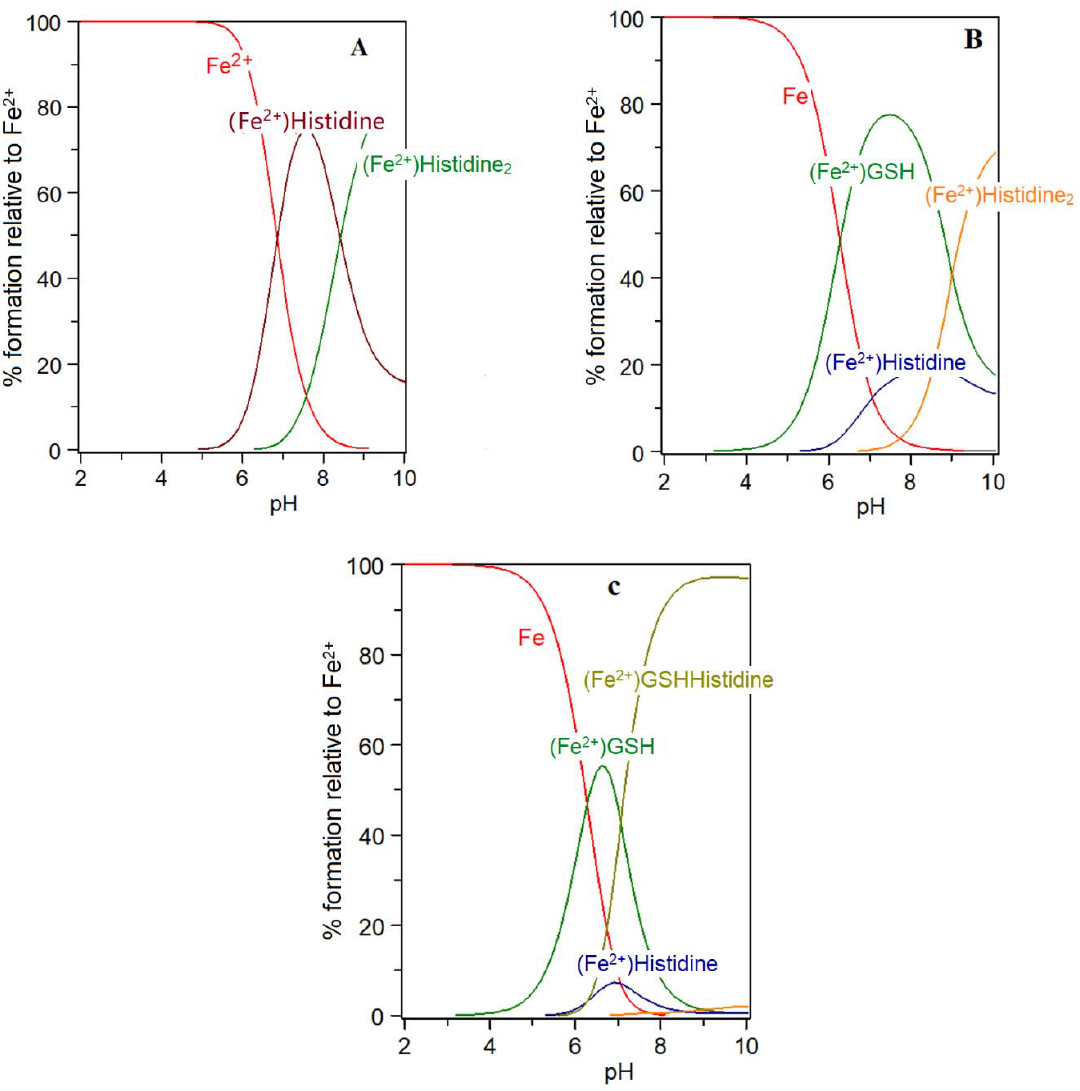
Figure 5. Speciation plots for histidine with Fe(II) in the presence and absence of glutathione (GSH): ( A ) histidine (300 µ M), Fe 2+ (1 µ M); ( B ) histidine (300 µ M), Fe 2+ (1 µ M), GSH (2 mM); and ( C ) histidine (300 µ M), Fe 2+ (1 µ M), GSH (2 mM) with the formation of the ternary complex assumed to be possible. LogK Fe ( II)-GSH = 5.1; logK Fe(II)-histidine = 5.85; logK Fe(II)-GSH-histidine = 10.95.